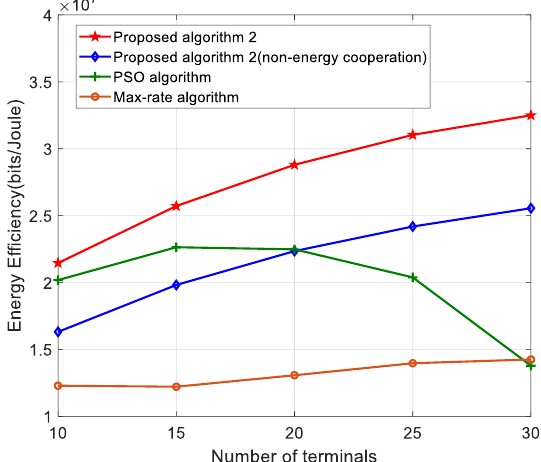
Figure 3. Energy efficiency versus number of terminals for different algorithms.